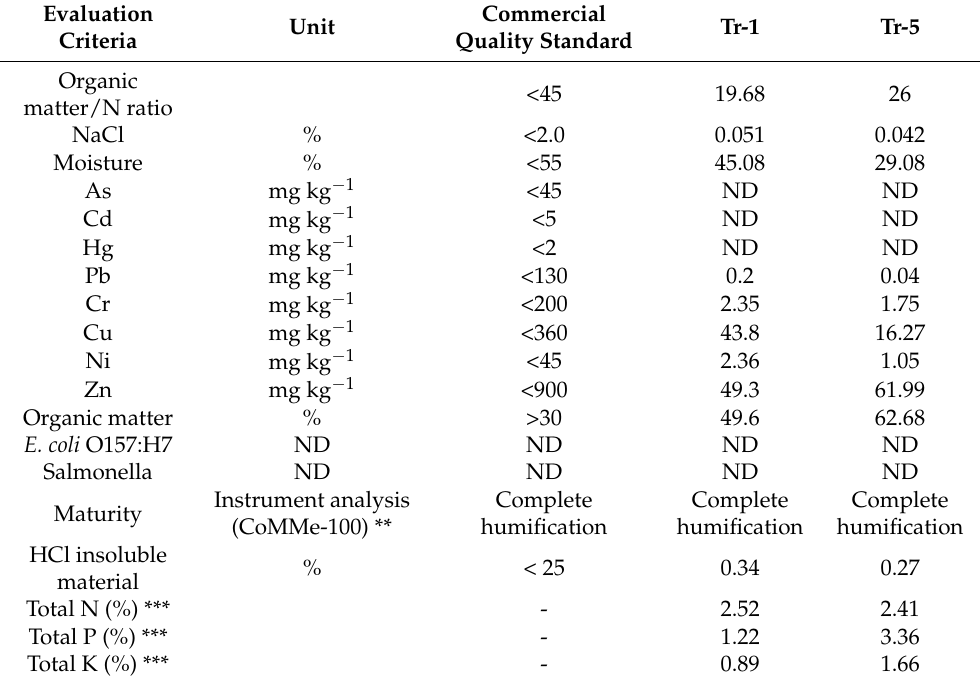
Figure 4. Effects of various SCG extracts on the growth of potential plant growth-promoting bacteria. ( A ) SCG in distilled water (10%, w / w ) and extracted by heat treatment (121 ◦ C for 15 min); ( B ) SCG in distilled water (10%, w / w ) and extracted by a shaking incubator (150 rpm) at 25 ◦ C for 1 h; ( C ) SCG suspended in 80% ethanol (10%, w / w ) and extracted by a shaking incubator (150 rpm) at 25 ◦ C for 1 h. Letters above the error bar indicates the comparison of samples using Duncan’s test. Table 5. Quality control data of the functional composts manufactured on the laboratory and pilot scales using SCGs, rice bran, biochar, and functional microbes